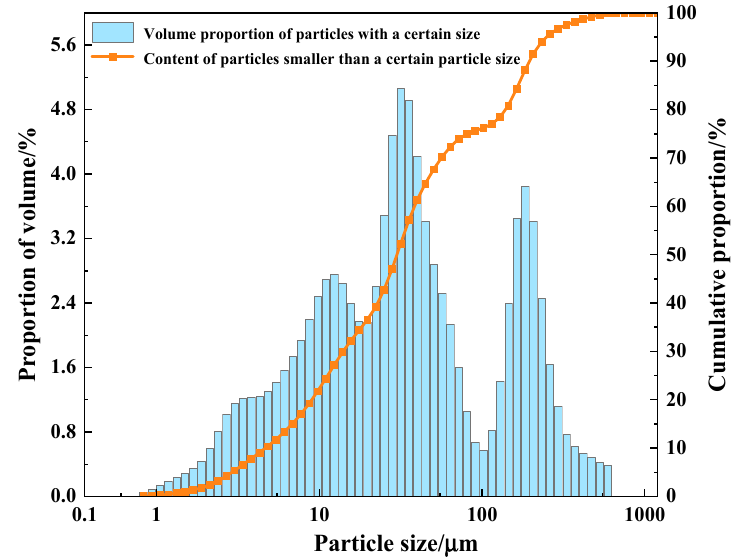
Figure 2. Particle size distribution of